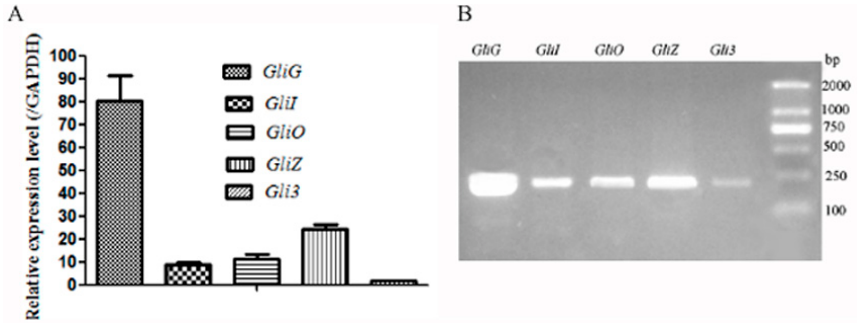
Figure 3. The expression levels of the main unigenes related to the gliotoxin biosynthesis: ( A ) qRT-PCR analysis; ( B ) The identification of qPCR products by electrophoresis.